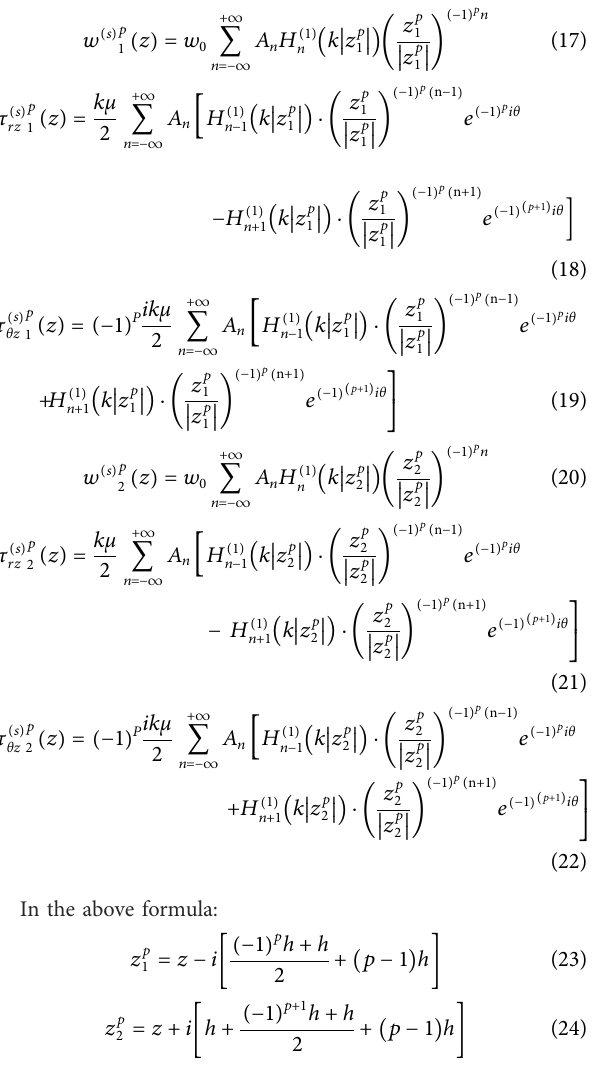
FIGURE 2 Trapezoidal